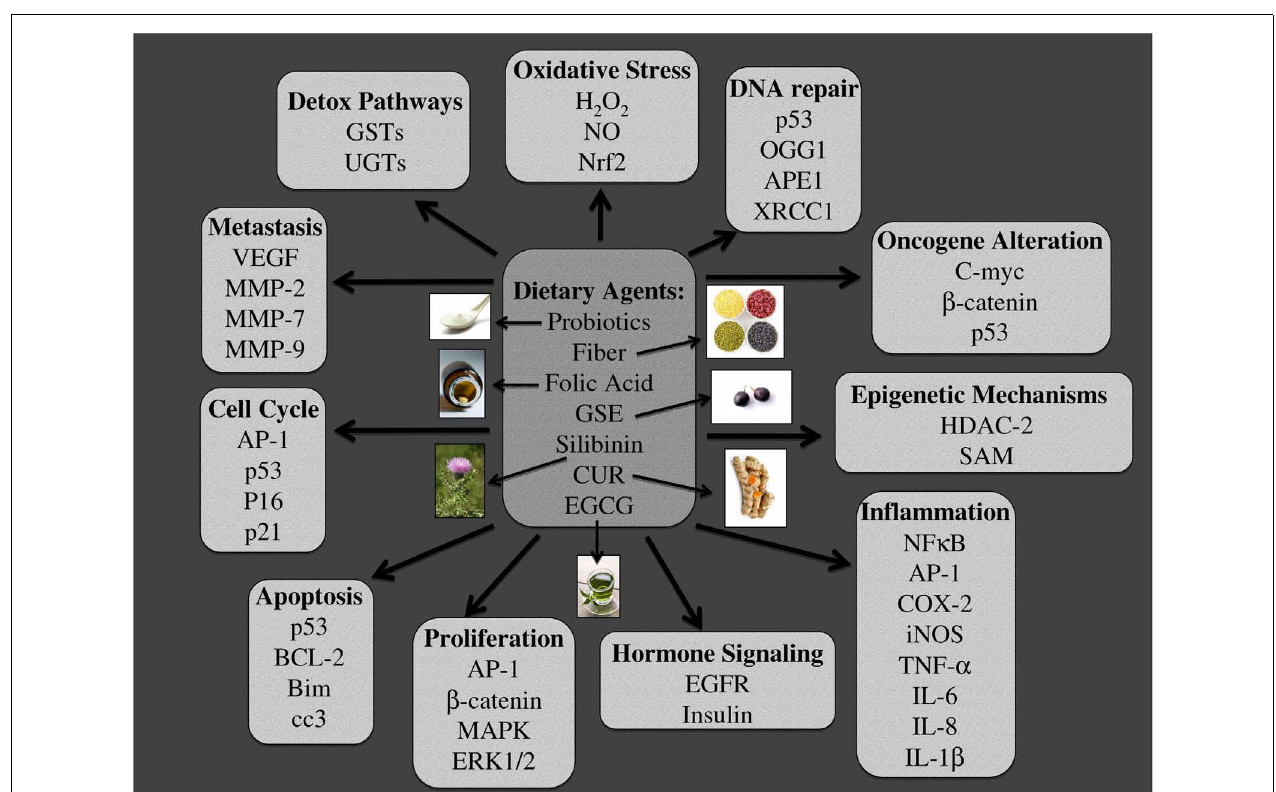
involved are those related to, detoxification, oxidative stress, DNA repair, oncogenesis, epigenetic silencing, inflammation, hormone signaling, proliferation, apoptosis, cell cycle, and metastasis.The photographs of dietary agents were sourced and adapted from http://www.freedigital